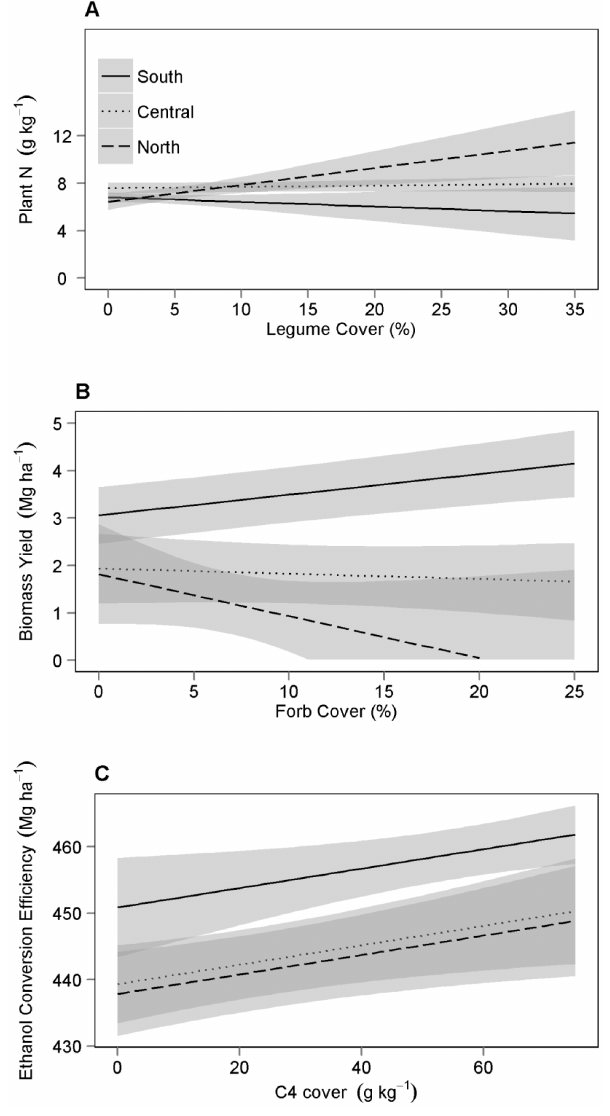
Figure 5. Estimated effect of plant functional group composi- tion on bioenergy potential. Regression line estimates( 6 90% CI) of the effect of legume cover on the concentration of N in biomass after harvest (A), the effect of forb cover on biomass yield (B), and the effect of C4 cover on ethanol conversion efficiency (C). Estimates are from the best fitting models with all other covariates held constant at their average values.